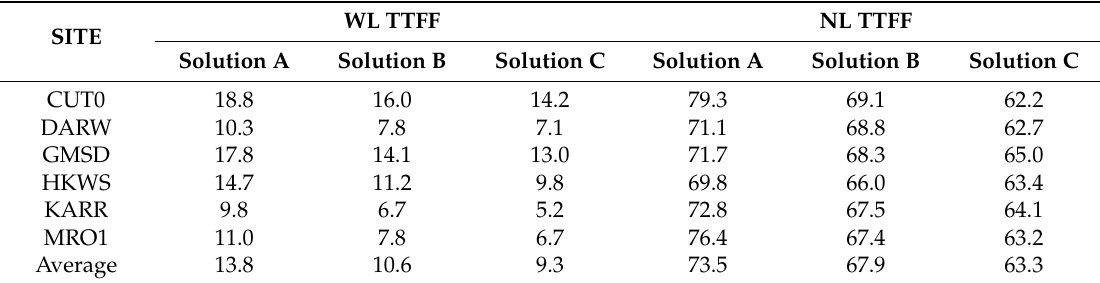
Table 4. The average TTFF (min) for kinematic PPP AR.